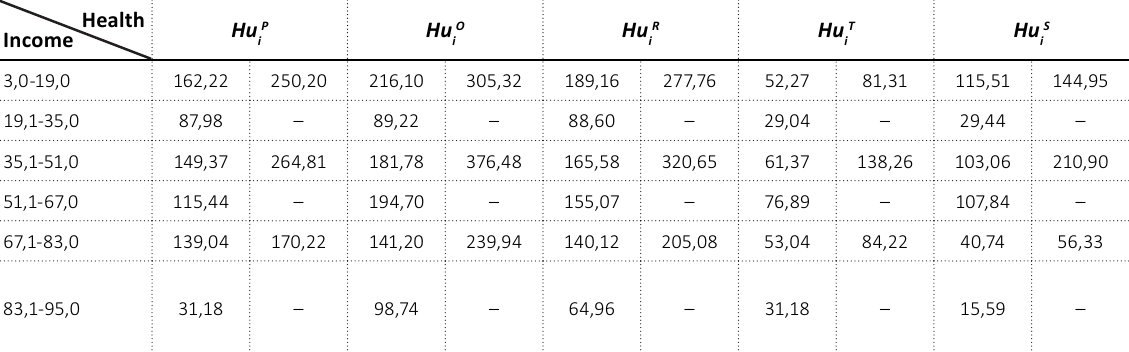
Table 5. Payoff matrix: Hurwitz criteria